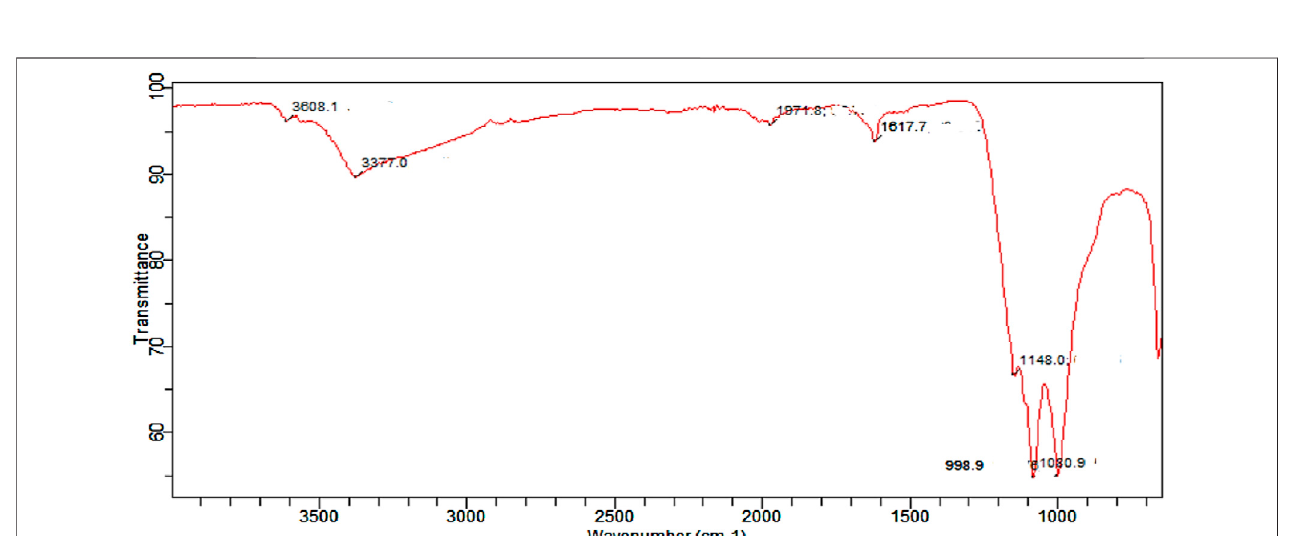
FIGURE 3 | FTIR spectrum of FSPD